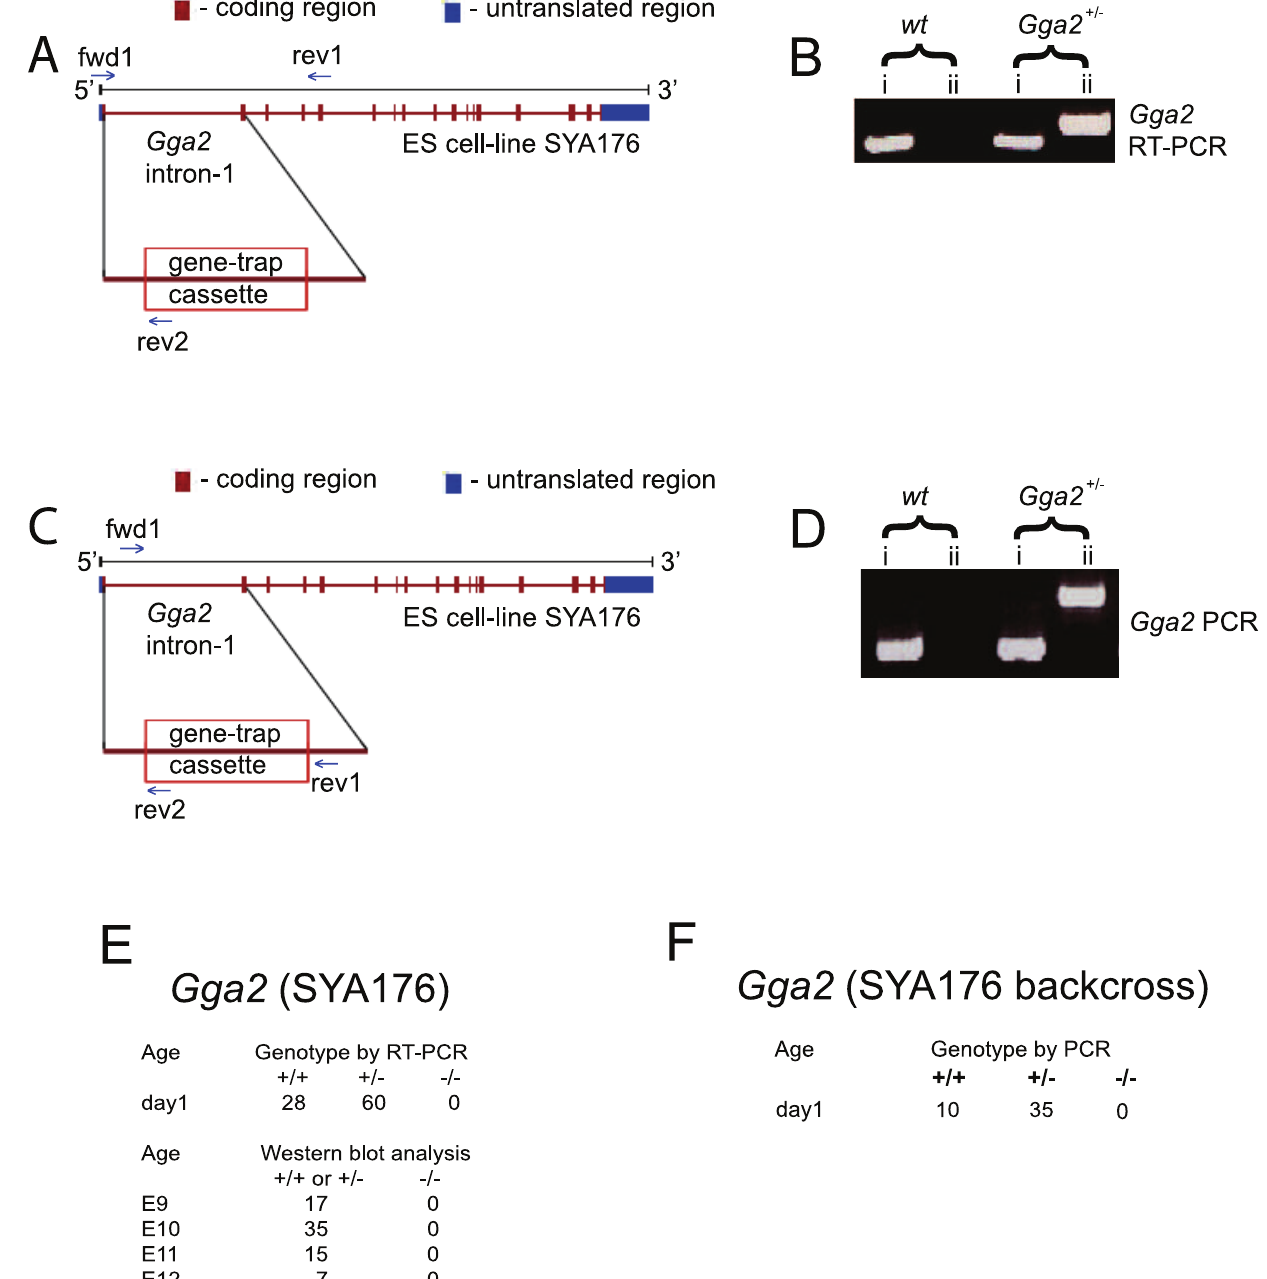
Figure 2. Analysis of Gga2 null mice (SYA176 strain). A) Insertion of the gene-trap cassette within intron-1 of the mouse Gga2 (SYA176) gene results in normal GGA2 mRNA being disrupted by the splice acceptor site of the engrailed-2 leader sequence fusing with codon-33 (encoding L33) of the mouse Gga2 gene. The progeny of Gga 2 + / 2 inter-crosses were genotyped by subjecting cDNA to RT-PCR with Gga2 primer sets fwd1/rev1 (spanning exons-1 through 5) and fwd1/rev2 (spanning exon-1 and the b -galactosidase exon) (Figure S1A), which differentiated between the wt and null genotypes, respectively. B) RT-PCR of cDNA prepared from white blood cells or brain tissue was performed using Gga2 specific primers (reactions i) or a Gga2 specific primer in combination with a gene trap specific primer (reactions ii). PCR band in reactions (i) indicates wt genotype, while PCR band in reactions (ii) indicates null genotype. C) Determination of the insertion site of the gene-trap within intron-1 of the mouse Gga2 gene (SYA176) allowed for the design of Gga2 primer sets fwd1/rev1 and fwd1/rev2 (Figure S1A), which clearly distinguished between wt and null genotypes, respectively, at the gene level. D) PCR of genomic DNA was performed using Gga2 specific primers (reactions i) or a Gga2 specific primer in combination with a gene trap specific primer (reactions ii). PCR band in reactions (i) indicates wt genotype, while PCR band in reactions (ii) indicates null genotype. E) The genotypes of the Gga2 + / 2 crosses were determined either by RT-PCR (day1 pups) or Western blots (embryos E9, E10, E11 and E12). No homozygous null were obtained out of 162 newborns or embryos that were analyzed. F) PCR was performed using genomic DNA from newborn pups of SYA176 Gga2 + / 2 crosses in the C57BL/6J background. No homozygous nulls were obtained out of 45 pups analyzed.